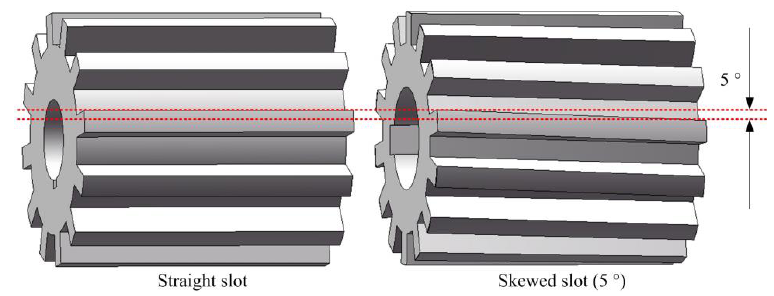
Figure 3. Straight-slot-type and skewed-slot-type rotors.